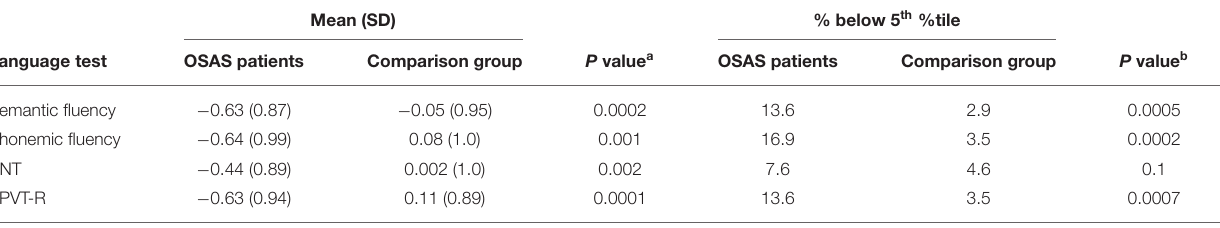
TABLE 2 | Performance of OSAS patients and comparison group on language